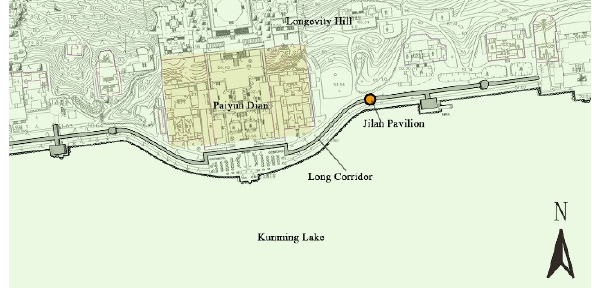
Figure 6: The plan around Jilan Pavilion